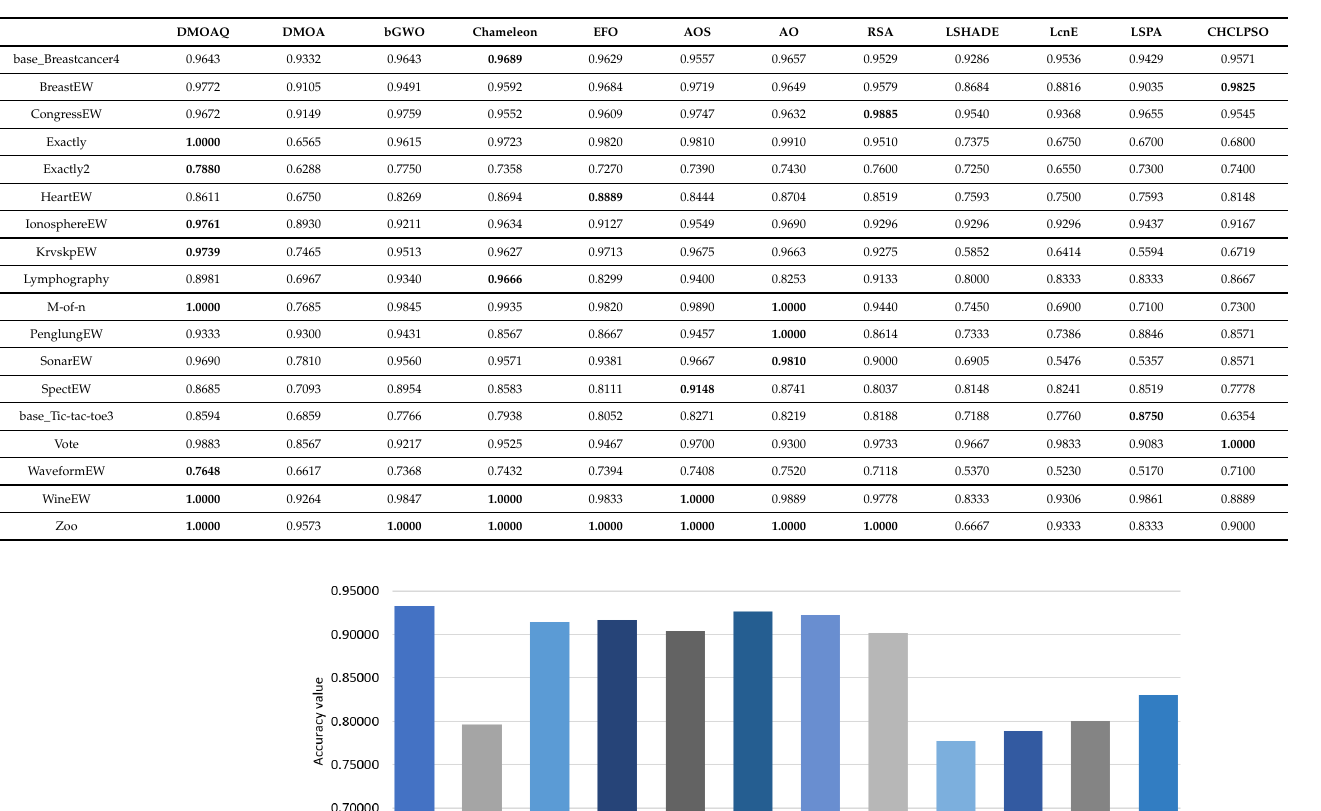
Table 7. Accuracy measure for all datasets.